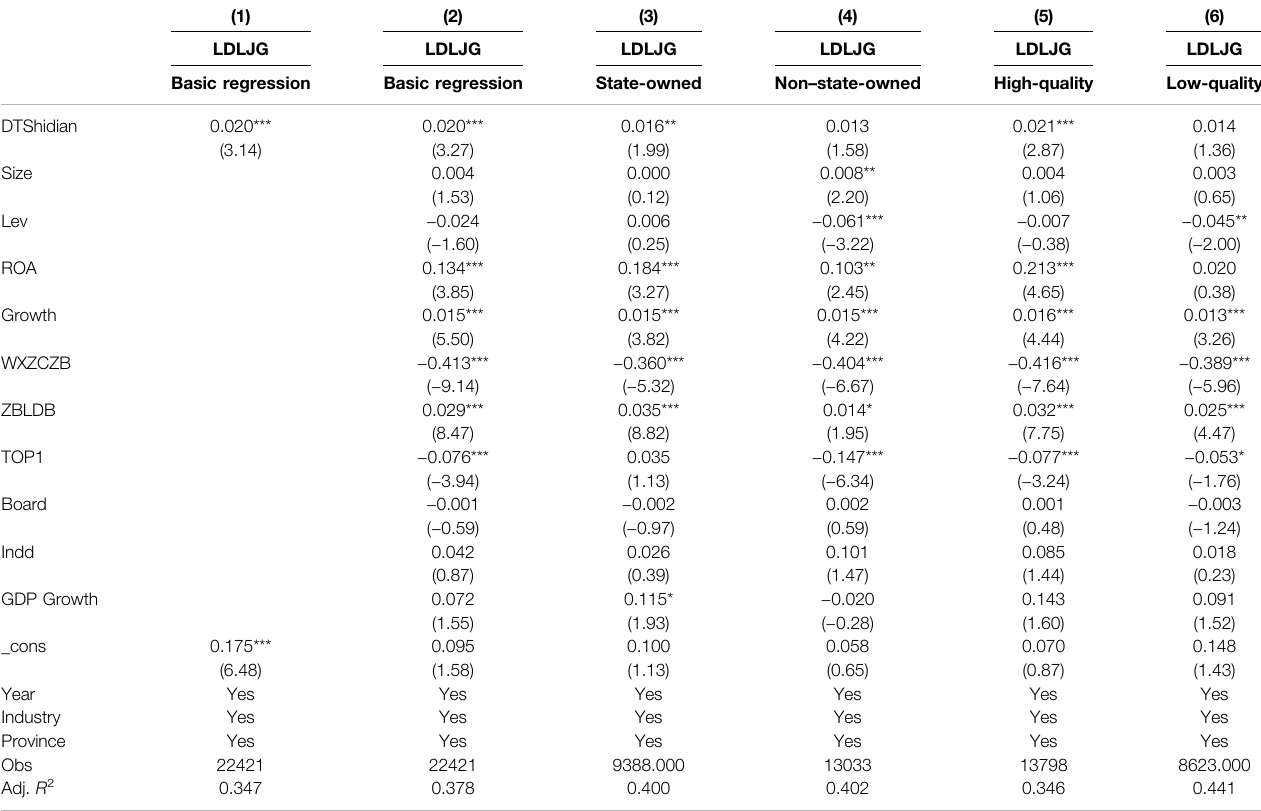
TABLE 4 | The impact of China ’ s pilot low-carbon city initiative on enterprise labor structure.